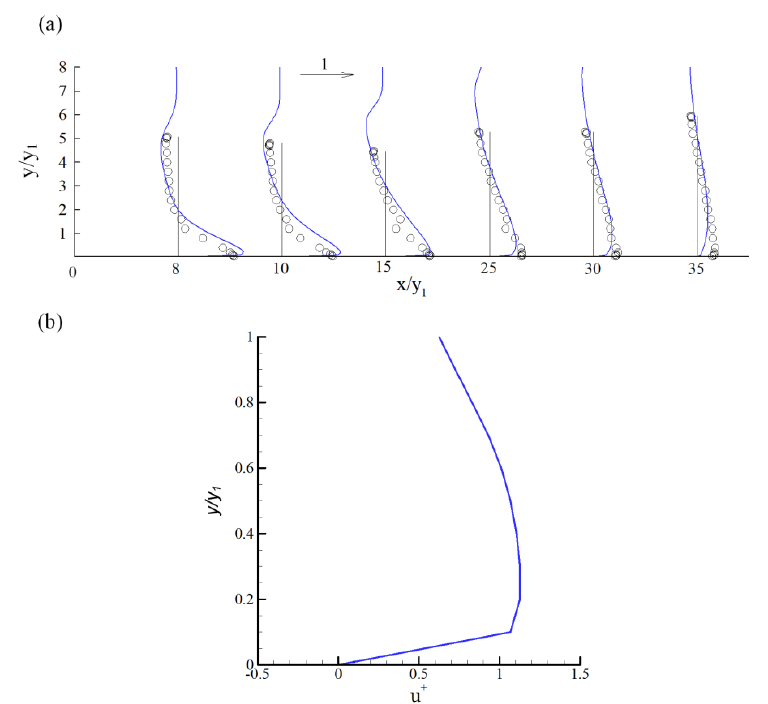
Figure 5. Comparison of velocity profiles at x/y 1 = 5 and z/b = 0.4 for different mesh resolutions.